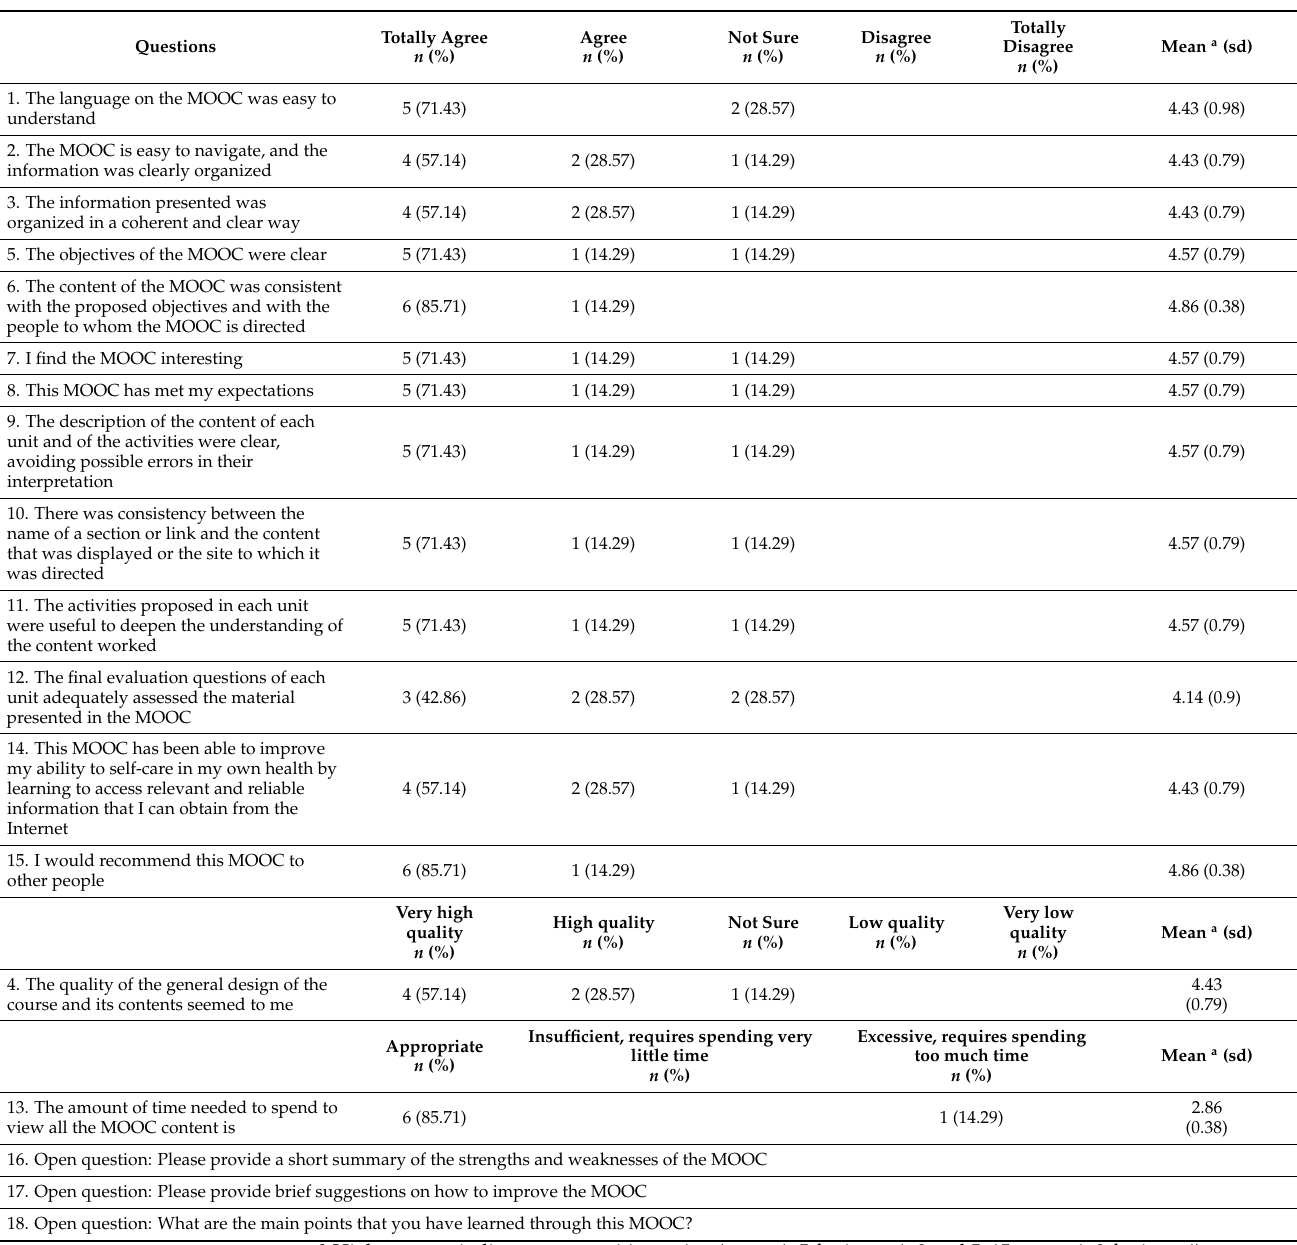
Table 4. Acceptability of the